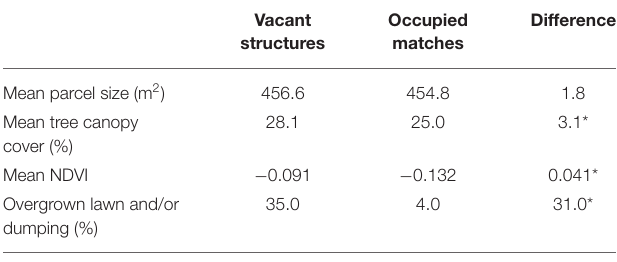
TABLE 2 | Comparison of vacant lot parcels and their occupied matches.